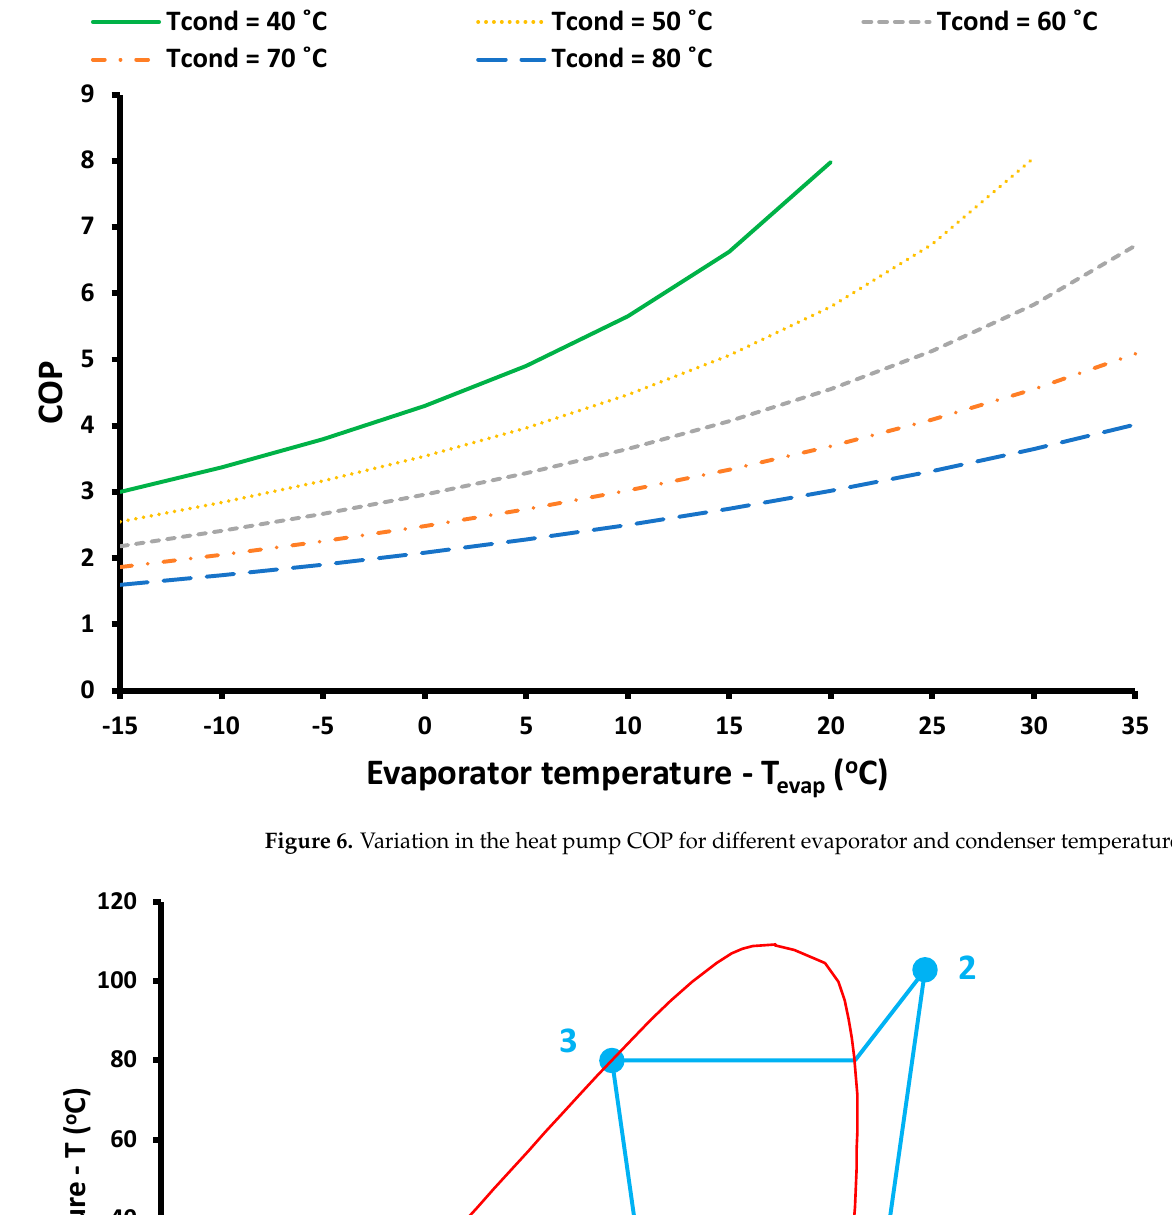
Figure 6. Variation in the heat pump COP for different evaporator and condenser temperature levels.